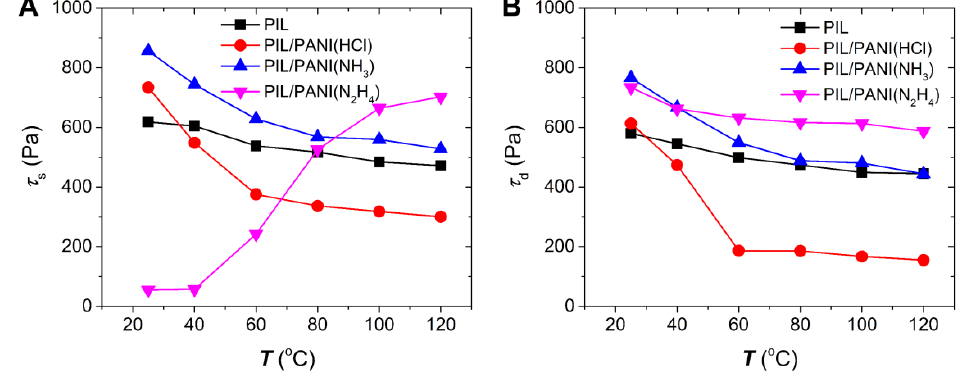
Figure 8. ( A ) Static yield stress and ( B ) dynamic yield stress at 3.0 kV / mm plotted as a function of temperature for the ER fluids of PIL / PANI